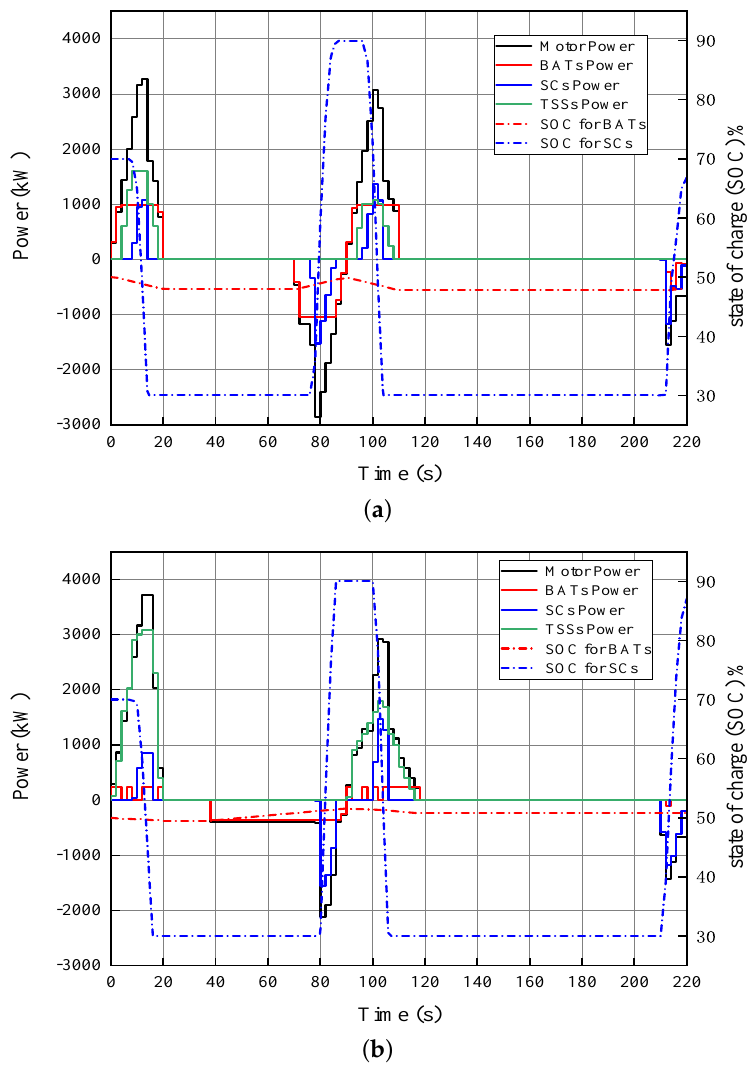
Figure 16. The motor power, TSSs power, discharge/charge power of on-board HESDs and SOC curves for cases 7–8. ( a ) case 7. ( b ) case